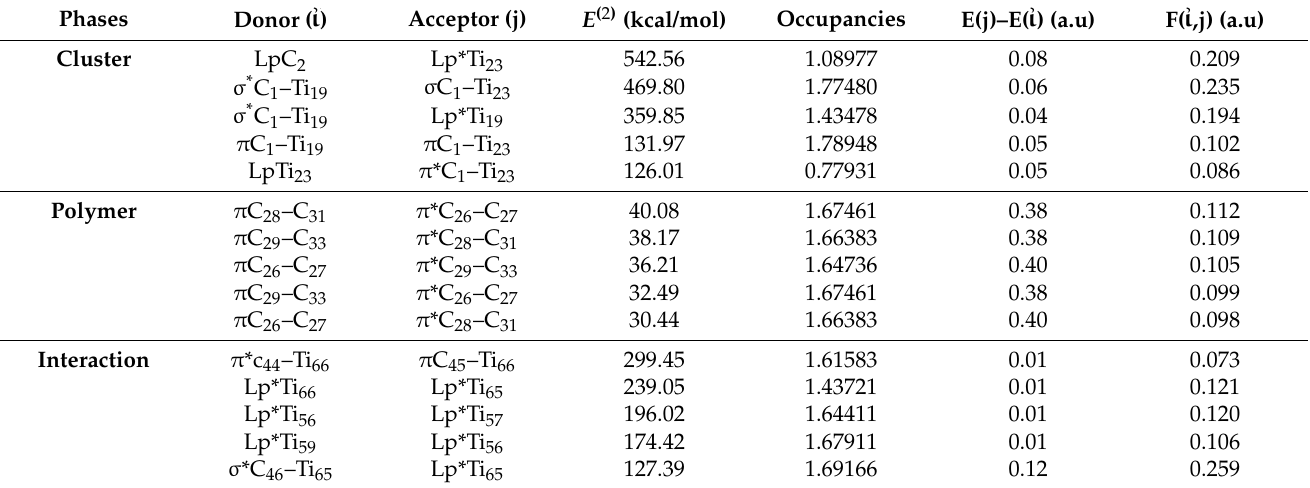
Table 2. Second-order perturbation analysis and occupancies of the Fock matrix for the studied